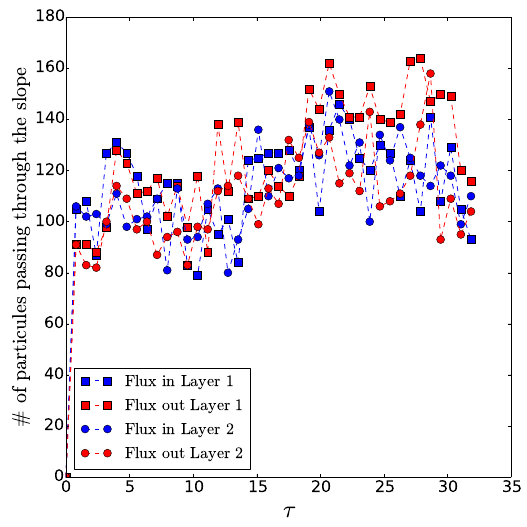
Figure 21. Particle evolution during the interaction of two cyclones for d / R = 3.4, γ R = 3, d c / R = 2. ( a ) Particles in the upper layer; ( b ) particles in the lower layer. The black contours indicate the topographic slope (Equation (12); straight lines) and the upper layer vorticity contours showing the two cyclone evolution.